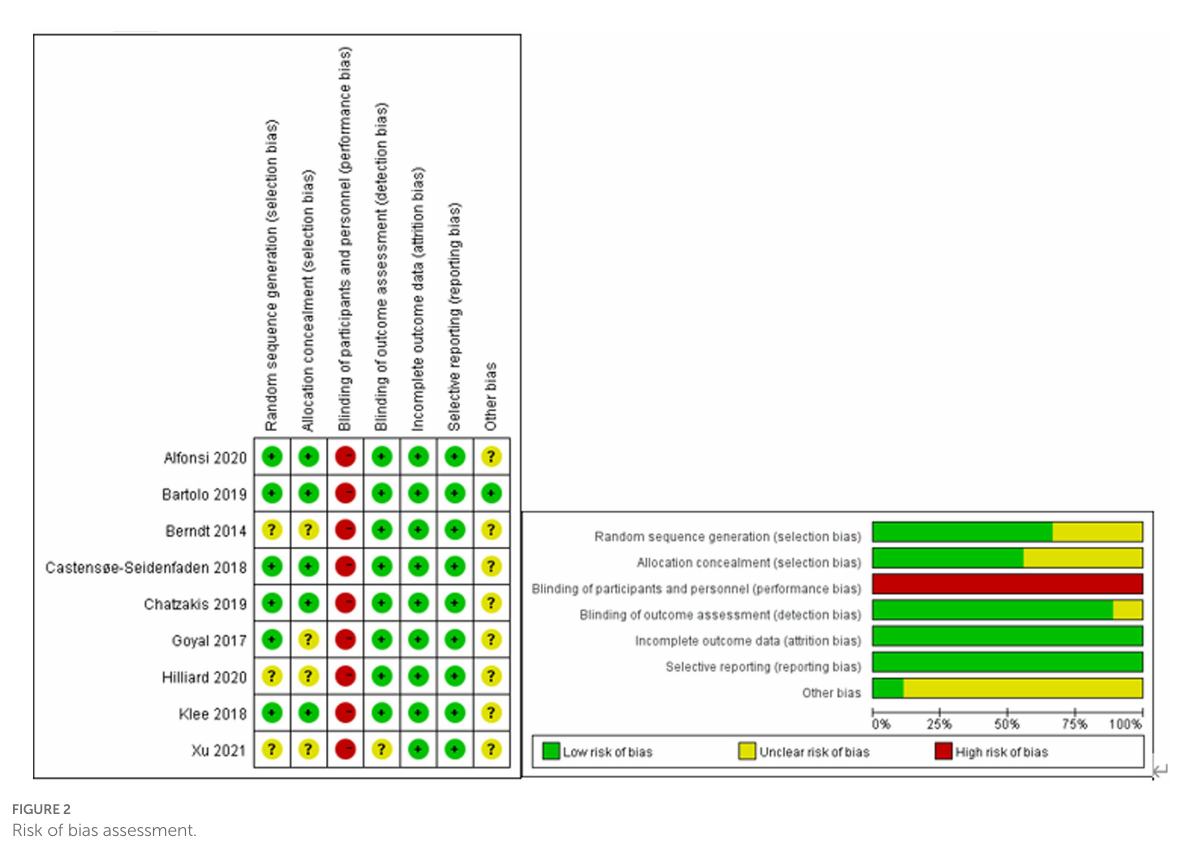
FIGURE 2 Risk of bias assessment.